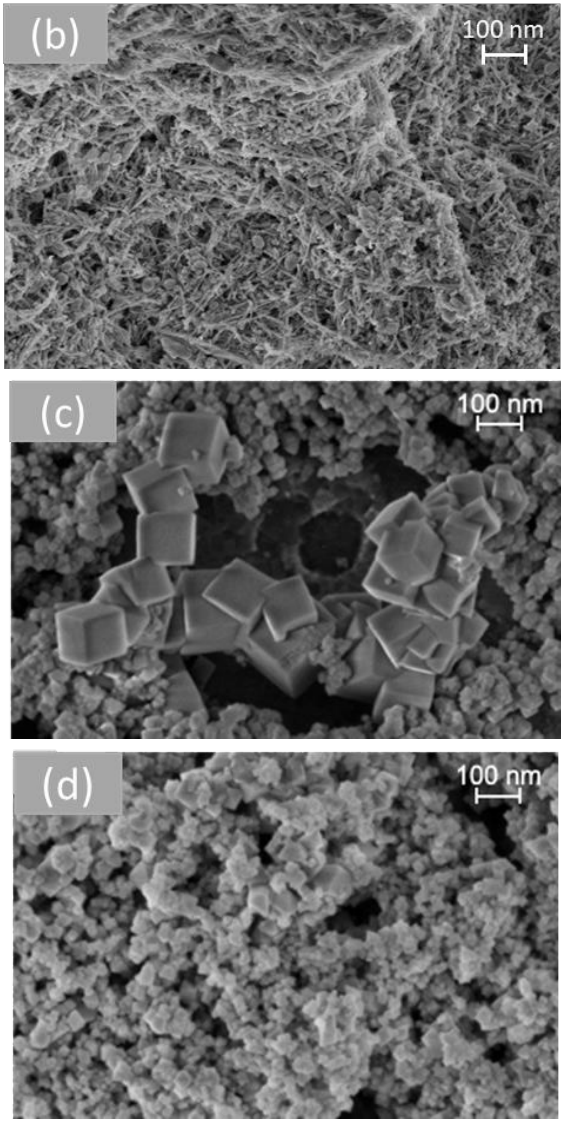
Figure 6. SEM analysis of cerium dioxide shapes: ( a ) CeO 2 polycrystalline, ( b ) CeO 2 rods, ( c ) CeO 2 cubes, and ( d ) CeO 2 octahedra. Table 3. The overall amount of hydrogen consumed in H 2 -TPR and oxygen consumed in CO 2 pulse